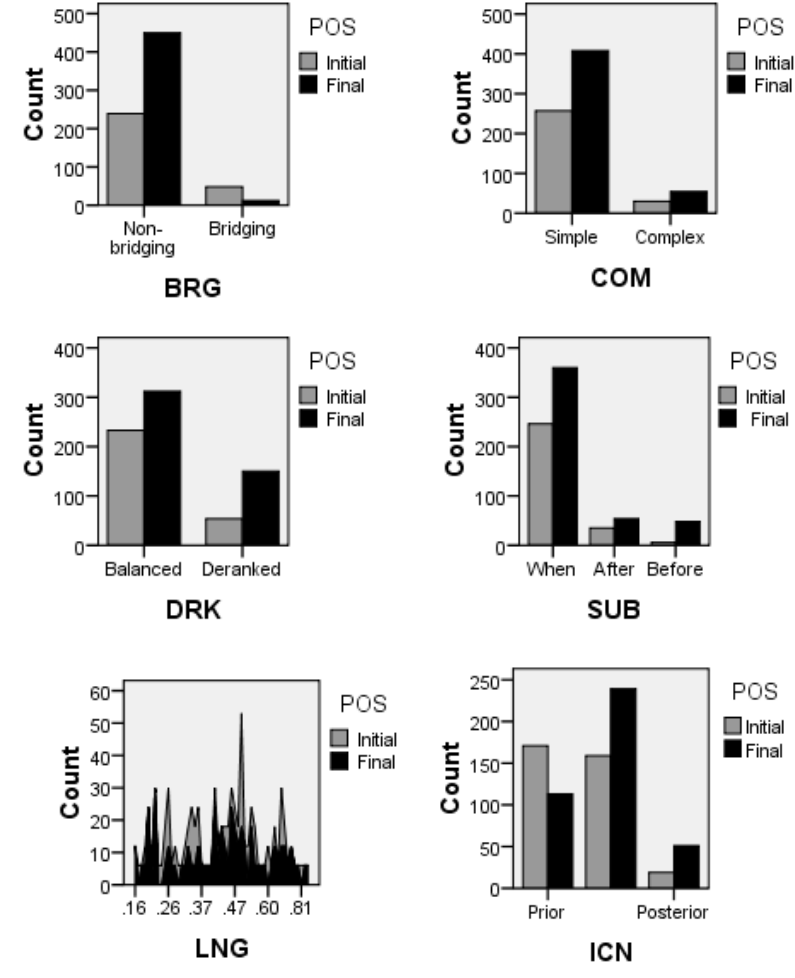
Figure 1: The distribution of the six predictors across the two